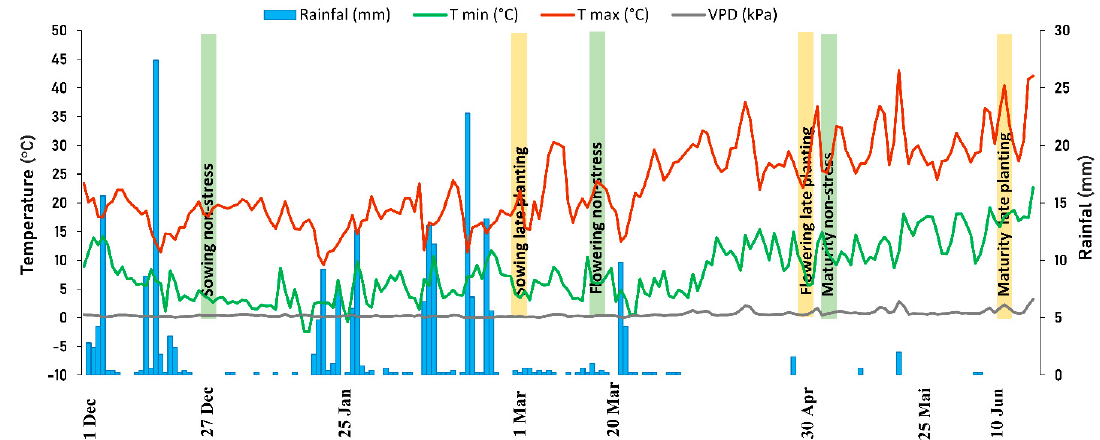
Figure 1. Rainfall, maximum and minimum temperatures, and vapor pressure deficit (VPD) during normal and late planting experiments in Marchouch, Morocco during 2016/17 season.